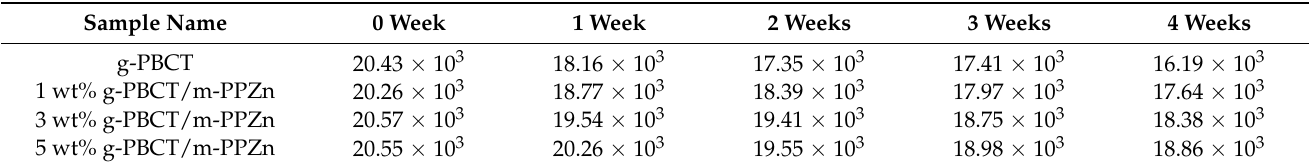
Figure 9. Change of number-average molecular weight (Mn) of g-PBCT and various weight ratio of g-PBCT/m-PPZn composites at different UV irradiation times. g-PBCT/m-PPZn composites at different UV irradiation times. Table 2. Number-average molecular weights (Mn) of g-PBCT/m-PPZn composites after 4 weeks UV